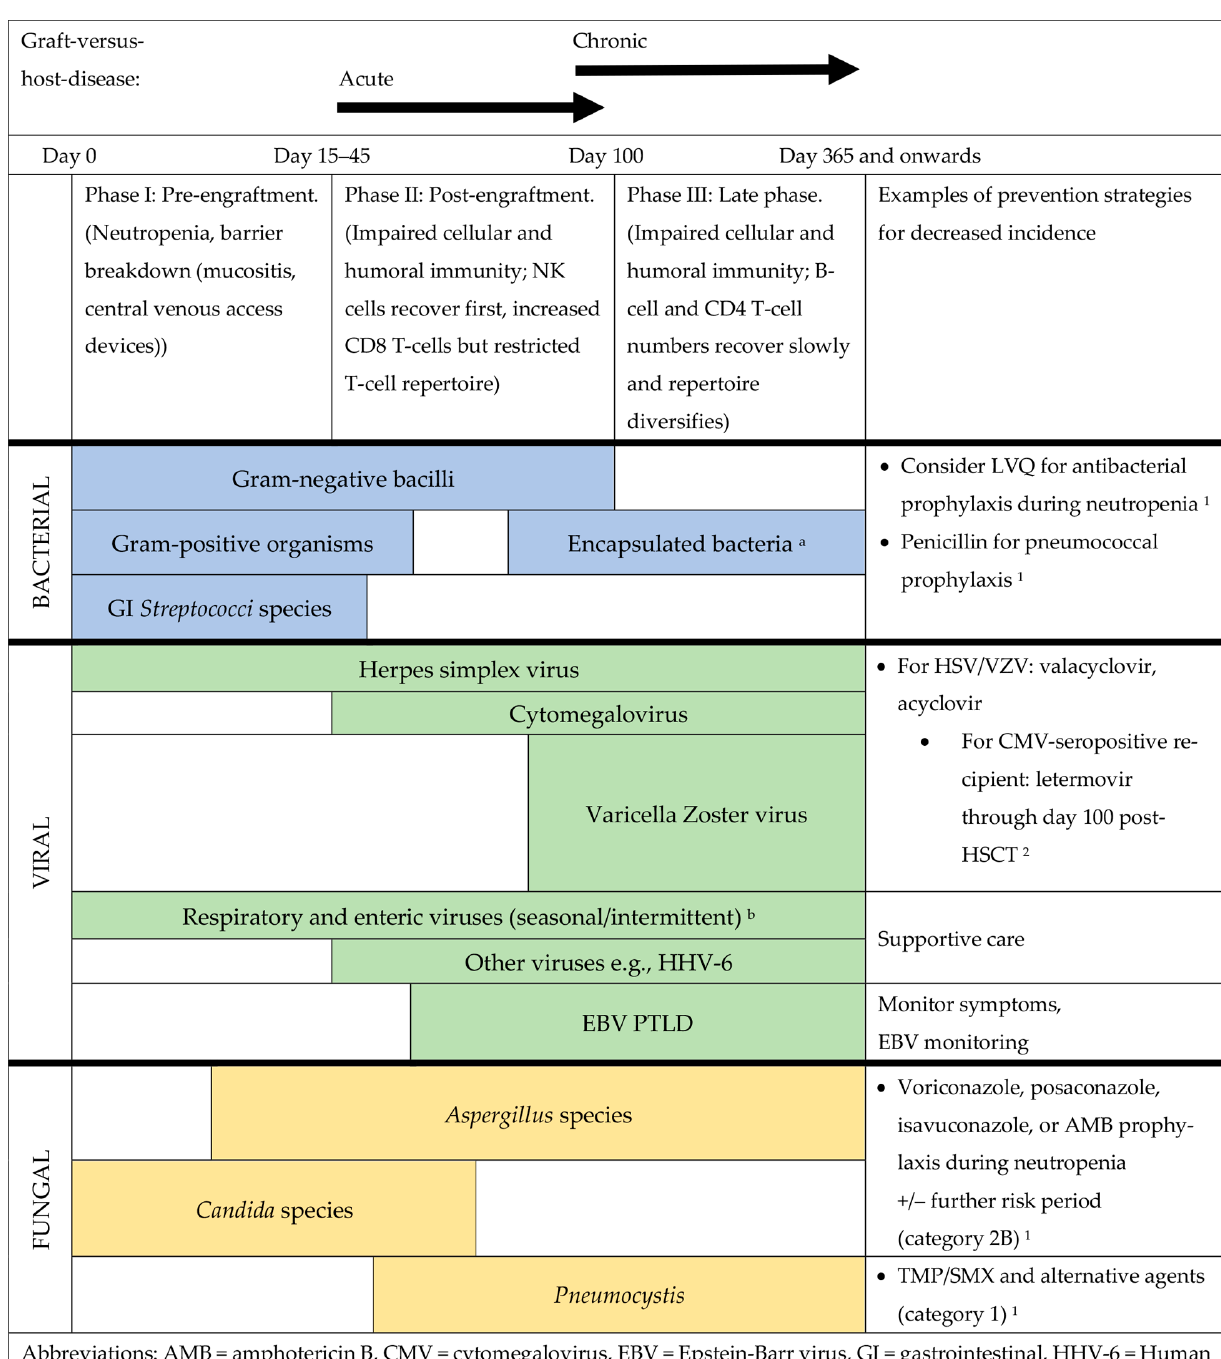
Figure 1. Phases of opportunistic infections among allogeneic HSCT recipients and examples of prevention strategies—Adapted with permission from Ref. [23]. Copyright 2016, Elsevier. 1 Refer- ence [11]. 2 Reference